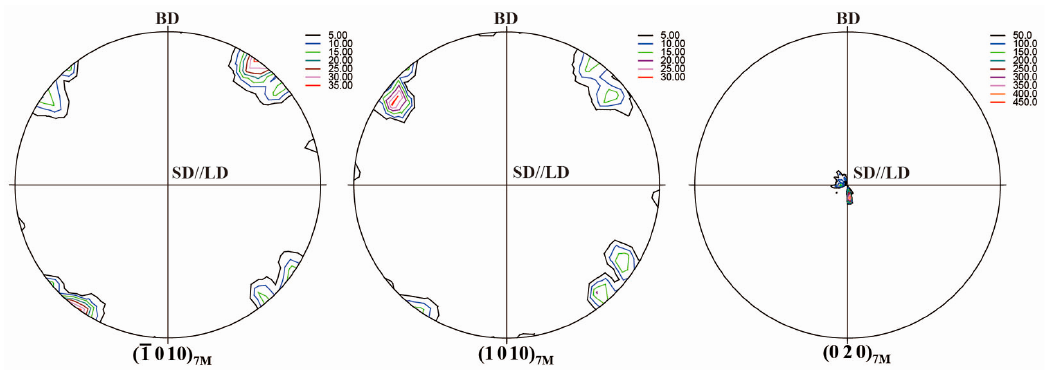
Figure 4. { − 1 0 10} 7M , {1 0 10} 7M and {0 2 0} 7M pole figures of 7M martensite after cyclic thermo-mechanical treatments measured from neutron diffraction for the directionally solidified Ni 50 Mn 30 Ga 20 alloy (BD: incoming beam direction; SD: solidification direction; LD: loading direction).